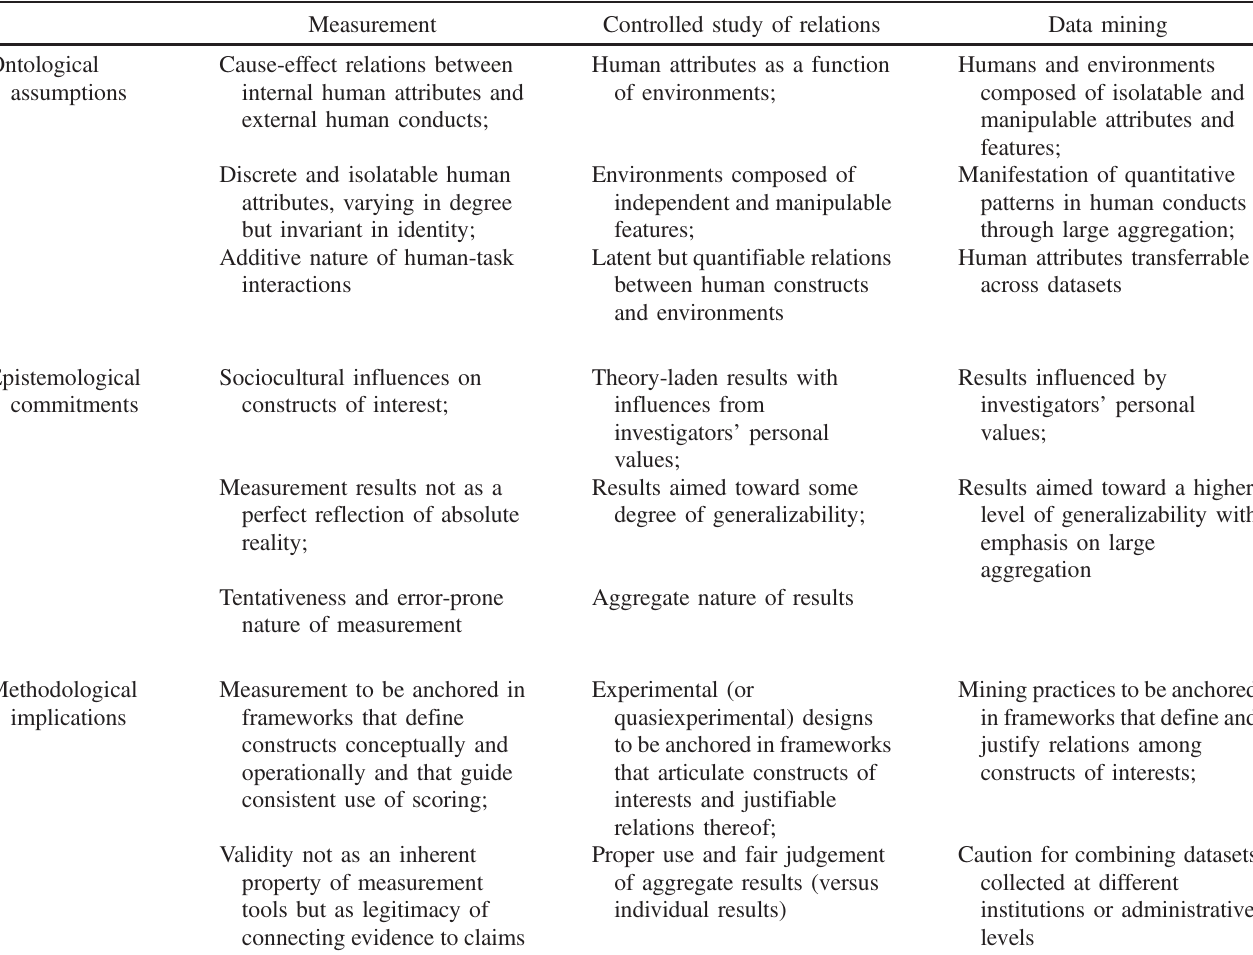
TABLE I. Paradigmatic summaries of the three quantification